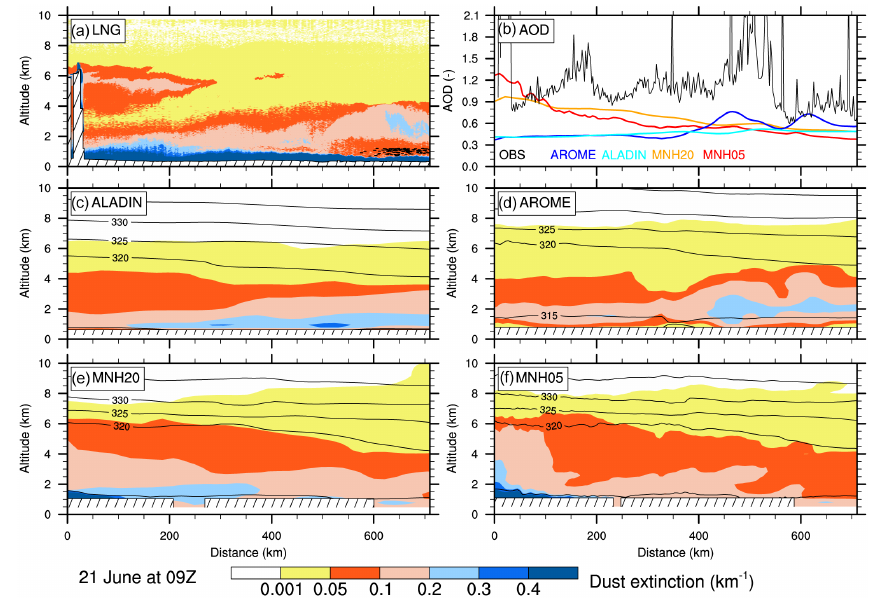
Figure 14. Same as in Fig. 12 but for the F22 flight on 21 June 2011. LNG observations were taken between 07:58 and 08:50UTC and forecasts are at